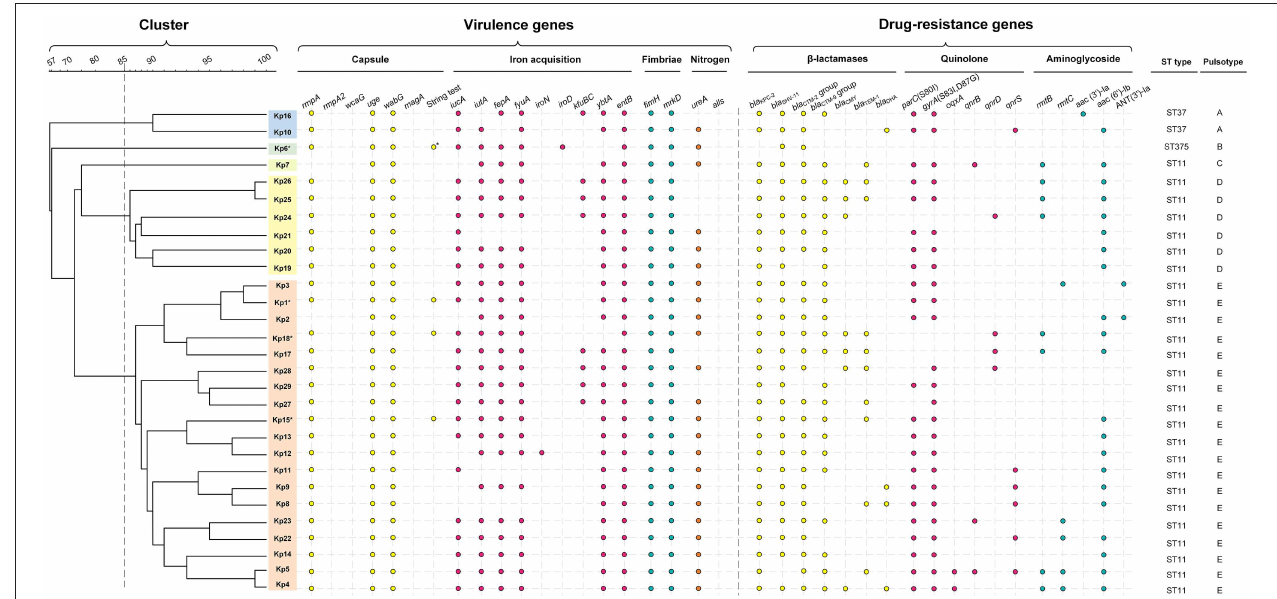
FIGURE 3 | Gene profiles of K. pneumoniae isolates. Virulence genes and drug-resistance genes identified by PCR-based profiling are shown by colored dots, plotted against the phylogeny of the strains from the whole genome PFGE analysis shown in Figure 2 . Asterisk indicates the capsule serotype was determined to be of K2 type. The relevant abbreviations are: bla , beta-lactamases (specific isoforms bla KPC − 2 , bla SHV − 11 , bla CTX − M − 2 group, bla CTX − M − 9 group, bla CMY − 2 , bla TEM − 1 , bla DHA ); mutations in gyrA (S83I, D87G) and parC (S80I), and the presence of qnrB , qnrS, and oqxA all reduce susceptibility to fluoroquinolones ( 42); rmtB, rmtC (encoding 16S rRNA methylases), aac(3’)-Ia, aac(6’)-Ib, and ANT(3’)-Ia (encoding aminoglycoside-modifying enzymes) are all aminoglycoside resistance